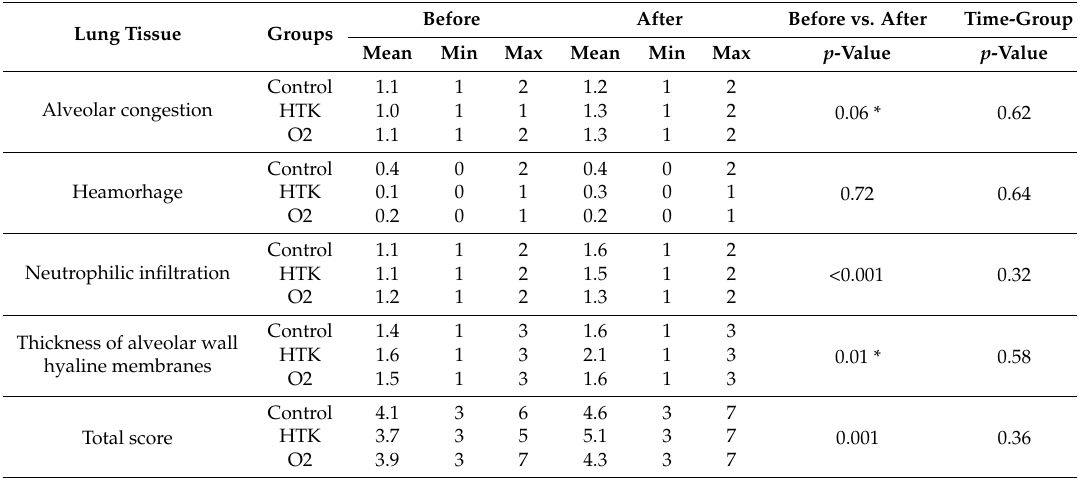
Table 2. Lung histopathological changes from before and after CPB. Before After Before vs. After Lung Tissue Groups